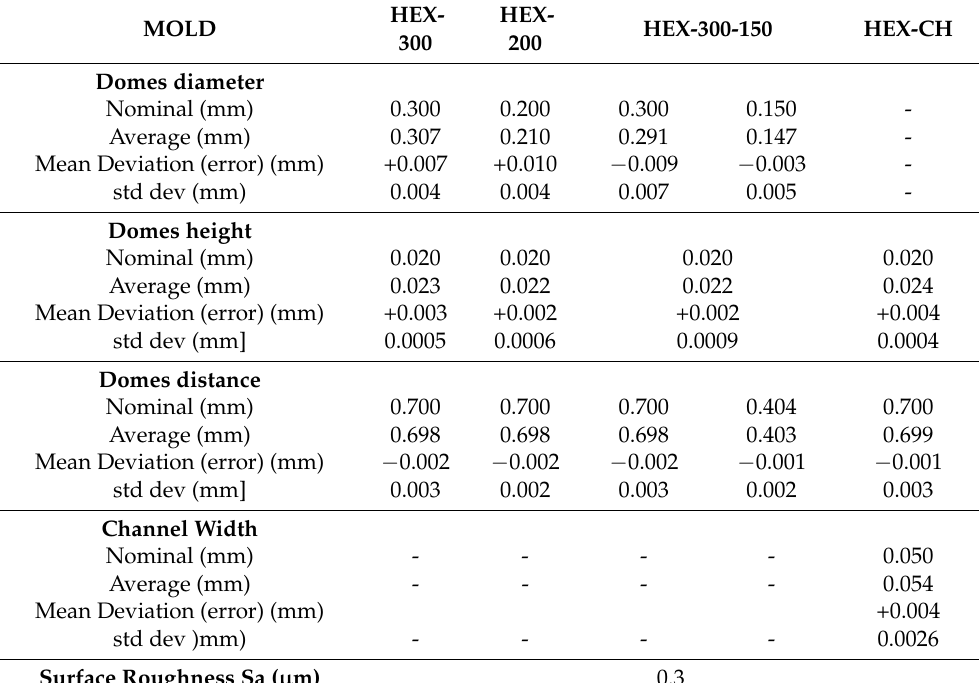
Table 5. Mold features’ measurements.